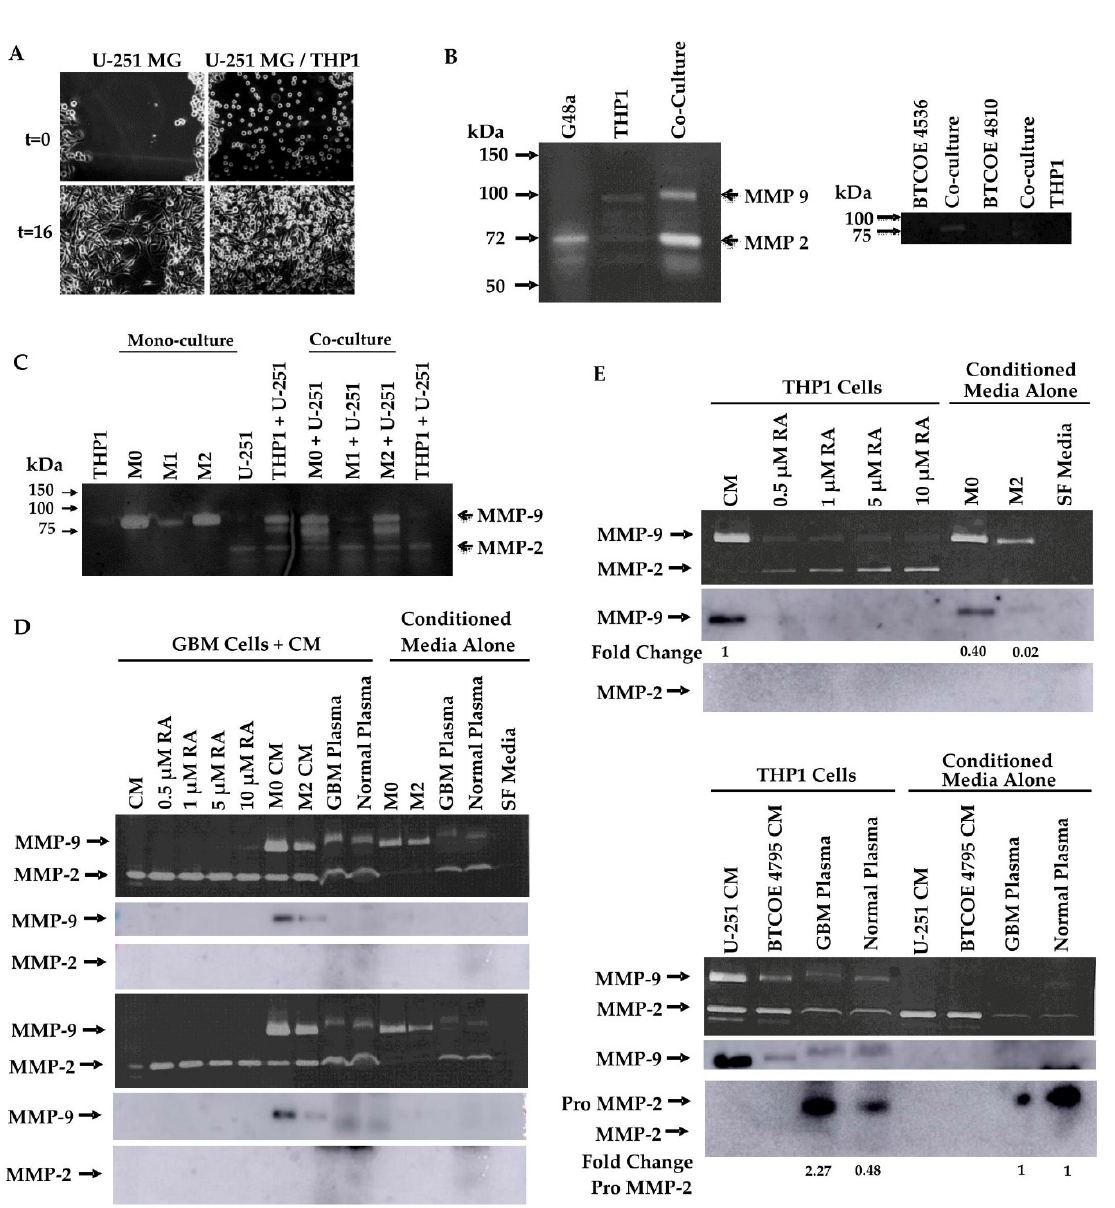
Figure 7. Retinoic acid modulates expression and activity of MMP-2 and MMP-9. ( A ) Scratch wound assay of GBM cells co-cultured with THP1 monocytic cells. Monoculture showed 74% wound closure while co-culture showed 91% closure ( p < 0.0001). Gelatin zymograms for MMP-2 and MMP-9 activity performed on ( B ) media from GBM cells, macrophages, and their co-culture, ( C ) differentiated THP1 (M: naïve, M0: activated) cells in monoculture and co-cultured with GBM cells, ( D ) GBM cells treated with increasing concentrations of RA, conditioned media from differentiated THP1 macrophages, and human plasma, (upper panel: U-251; lower panel: BTCOE 4795). MMP-2 activity in BTCOE 4795 cells was significantly increased in 0.5 uM RA ( p = 0.0002) and 1 uM RA ( p = 0.003) treatment groups by one-sample t -test. MMP-9 activity in BTCOE 4795 cells was significantly increased in M0 CM treatment group ( p = 0.03). Zymogram of ( E ) THP1 cells treated with RA, conditioned media from GBM cells, and human plasma. MMP-9 activity was significantly decreased in each RA treatment group ( p = 0.0004, p = 0.005, p = 0.004, p = 0.007, respectively) and in M2 CM ( p = 0.03). M2 CM also showed significantly decreased MMP-9 activity compared to M0 CM ( p = 0.03). Zymograms and blots are representative of at least 2 experiments performed.